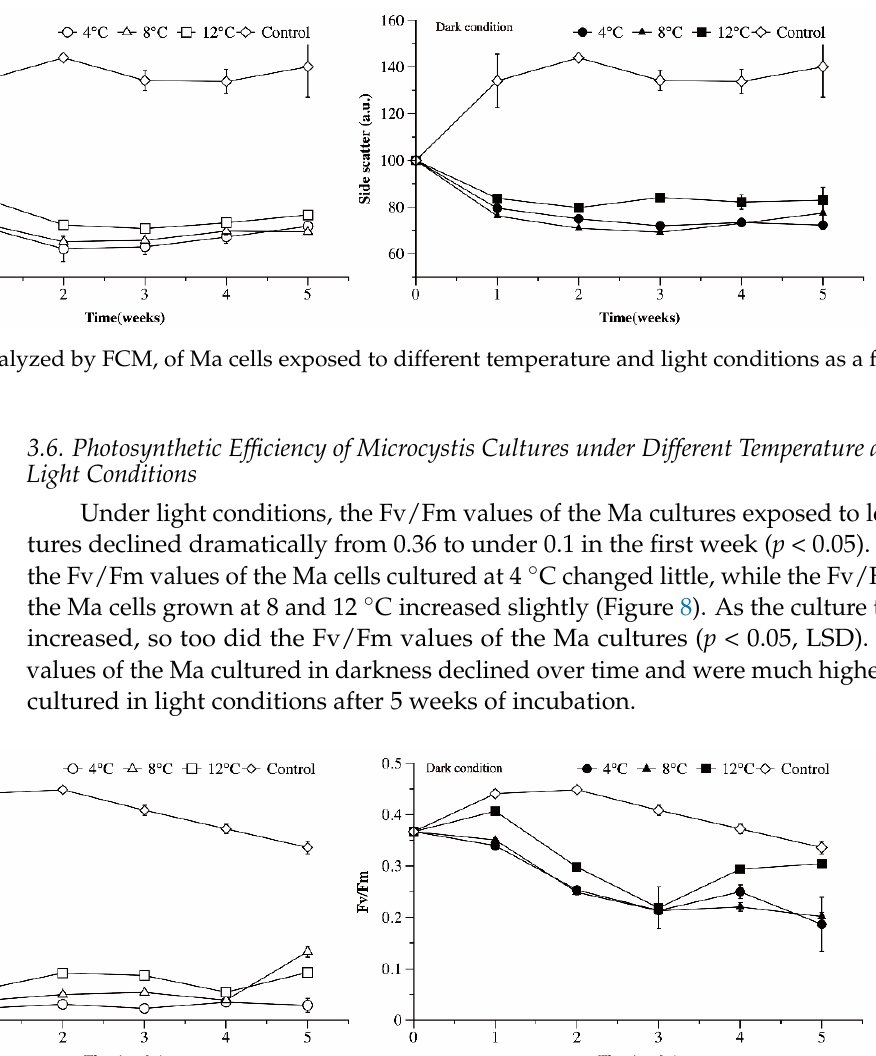
Figure 8. The maximum quantum yield for primary photochemistry (Fv/Fm) of Microcystis cultures exposed to different temperature and light conditions as a function of time.